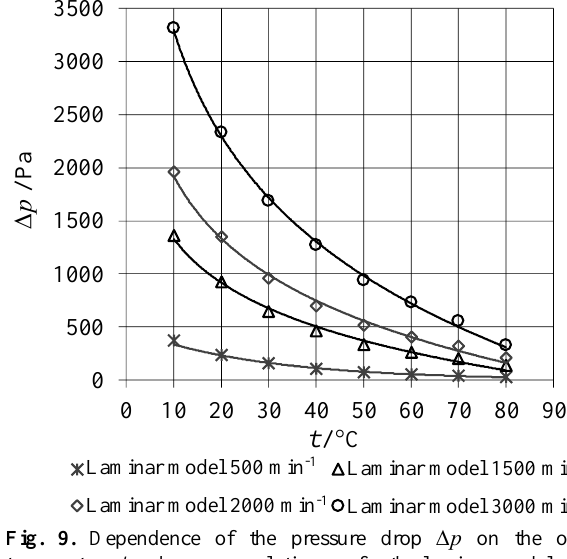
Fig. 9. Dependence of the pressure drop ∆p on the oil temperature t and pump revolutions n p for the laminar model In Figure 9, it is possible to observe that the pressure drop ∆p decreases with the increasing oil temperature t at the suction line. It is also visible in Figure 9 that the pressure drop of the suction line ∆p increases with the increasing pump revolutions n p (the flow velocity v ).